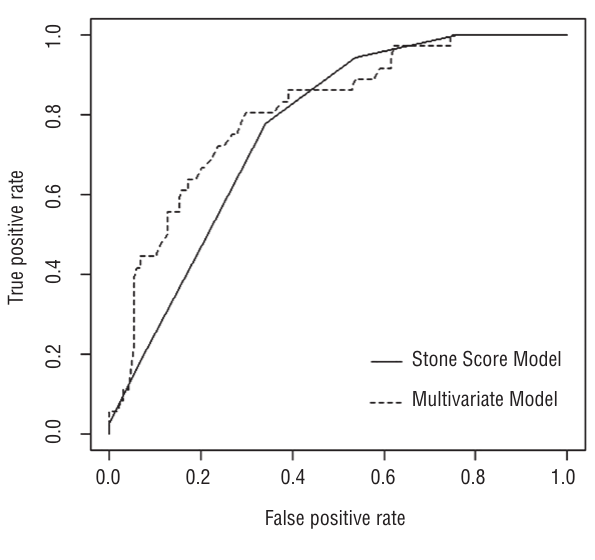
Figure 1 - Receiver operator curves for the S.T.O.N.E. Score (AUC = 0.764) and the Multivariate Regression Model (AUC =